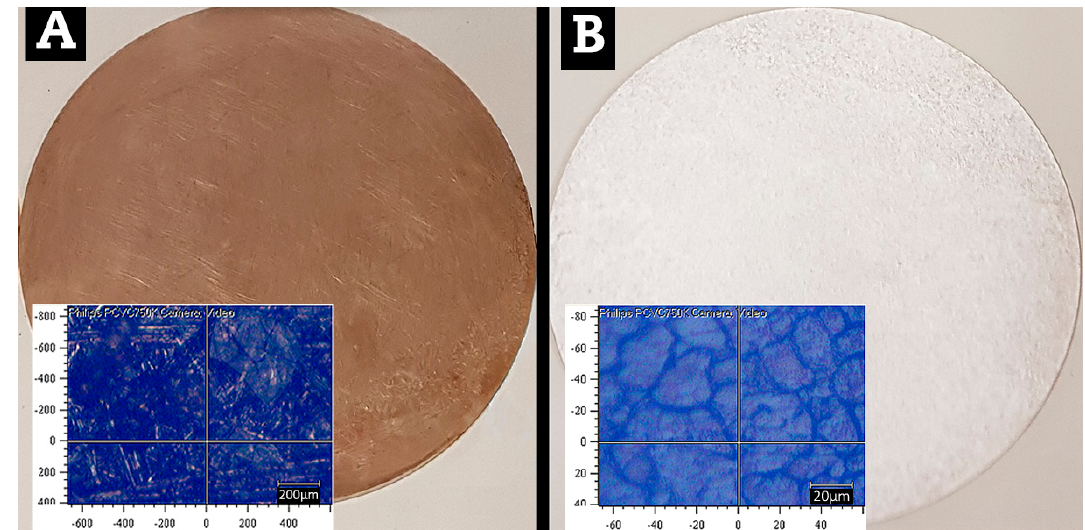
Figure 1. ( A ) Disc after silica interlayer coating and ( B ) after Ce-ZnO coating—both with optical microscopy images inset.